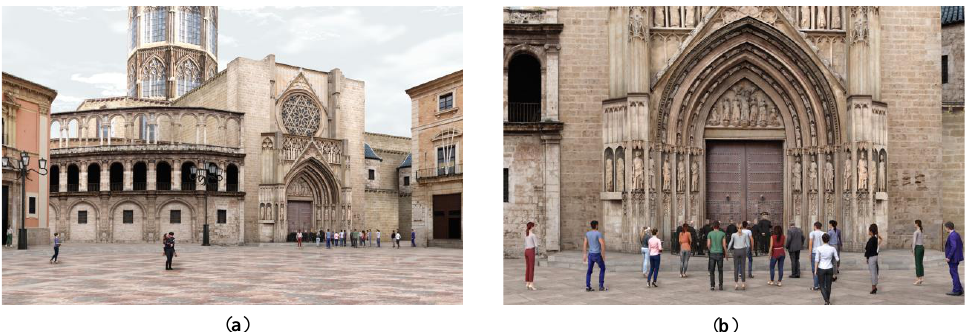
Figure 13. ( a ) Visual simulation overview of the environment of the Water Tribunal. ( b ) Detail of the representation of a session of the Water